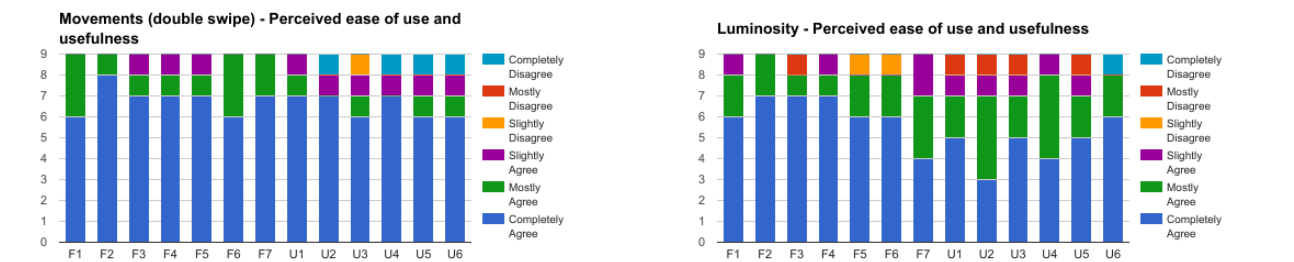
Fig. 9. T2 Movements (double swipe) - Perceived ease of use and usefulness.